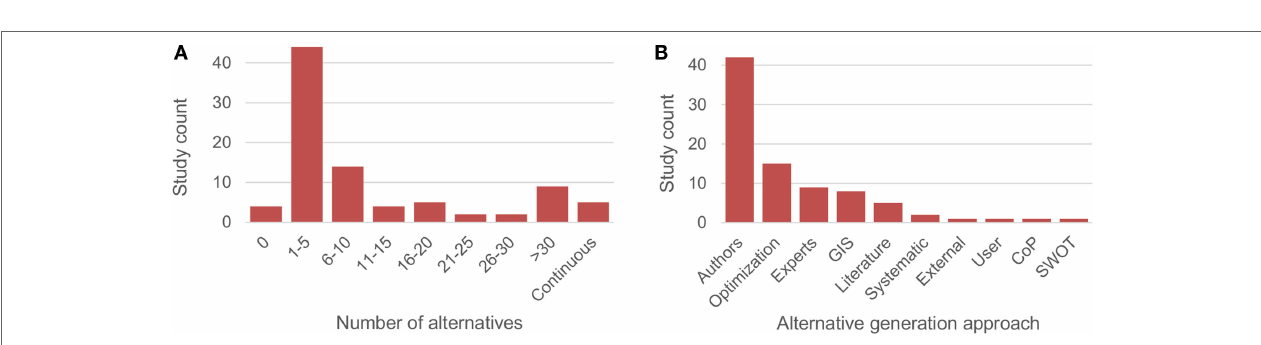
FiGURe 5 | Boxplots of the temporal planning horizons covered by the studies in each planning focus category . The average values for each category are based, respectively, from left to right on 63, 18 and 8 studies. Tukey style whiskers extend to points within 1.5 times the interquartile